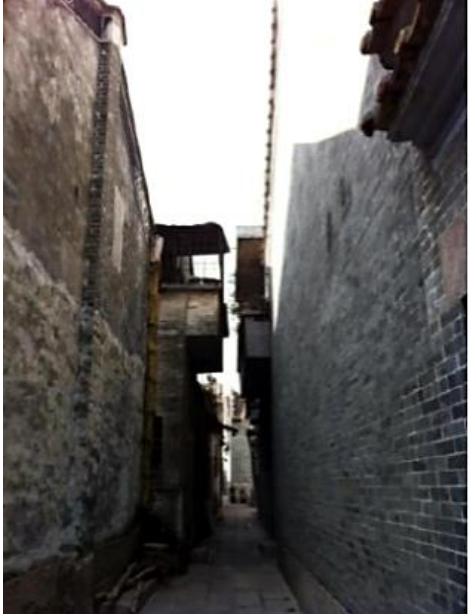
Figure 8. A balcony stretching over the laneway (source: the authors).